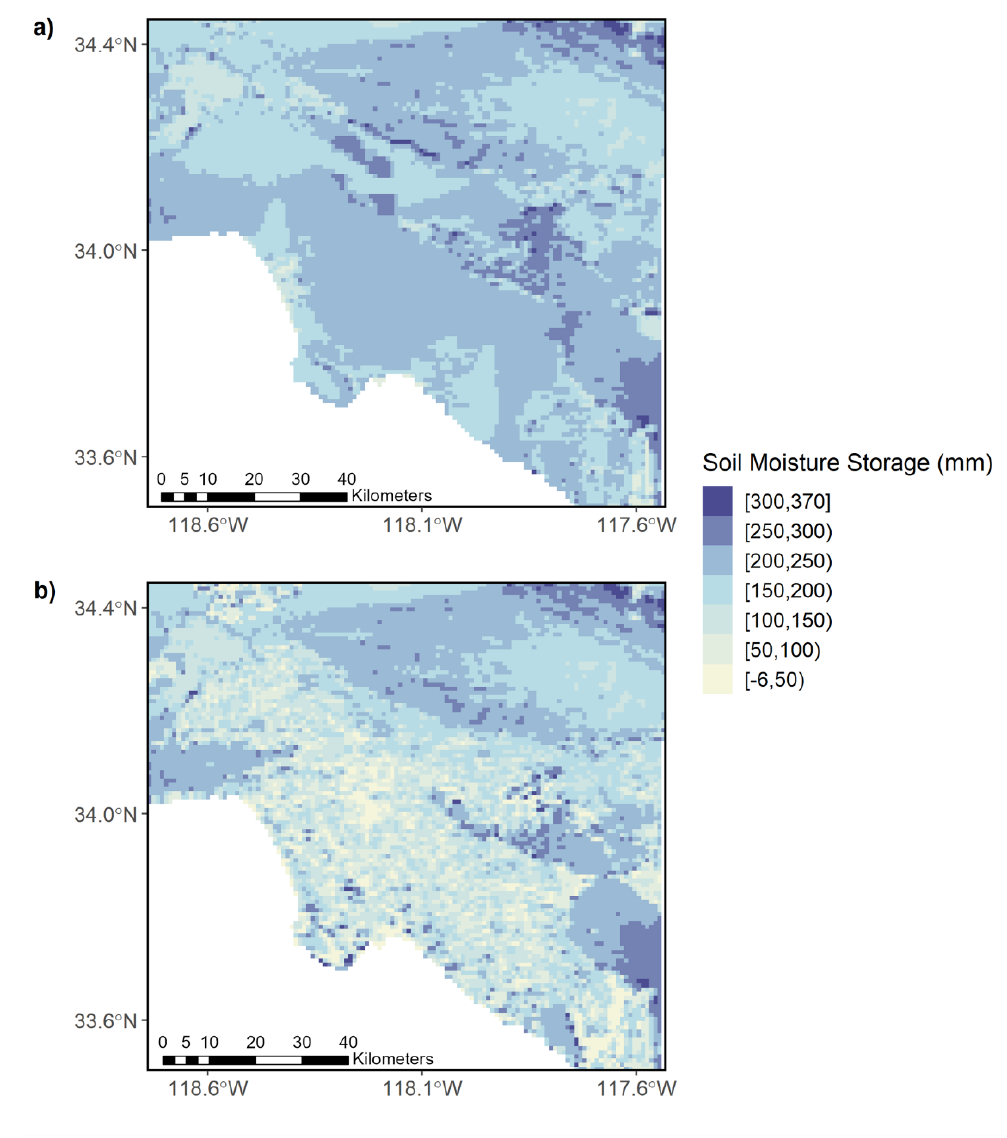
Figure 10. Soil moisture storage (2 m soil column) in the LA metropolitan area over the December 2010 precipitation event for ( a ) the pre-urban development scenario without impervious surfaces and ( b ) the post-urban development scenario under present imperviousness conditions.